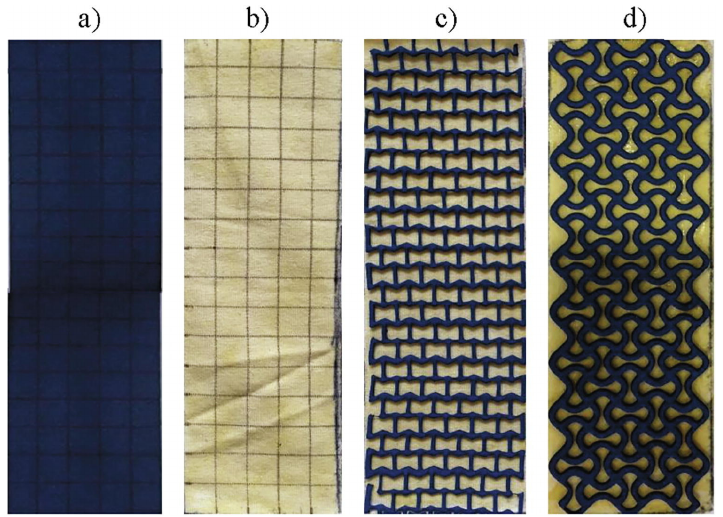
Figure 9. Analyzed specimens: ( a ) EVA foam, ( b ) fabric (with an adhesive), ( c ) re-entrant auxetic laminate, and ( d ) chiral auxetic laminate. Reprinted from [66], Copyright (2020), with permission from Elsevier.